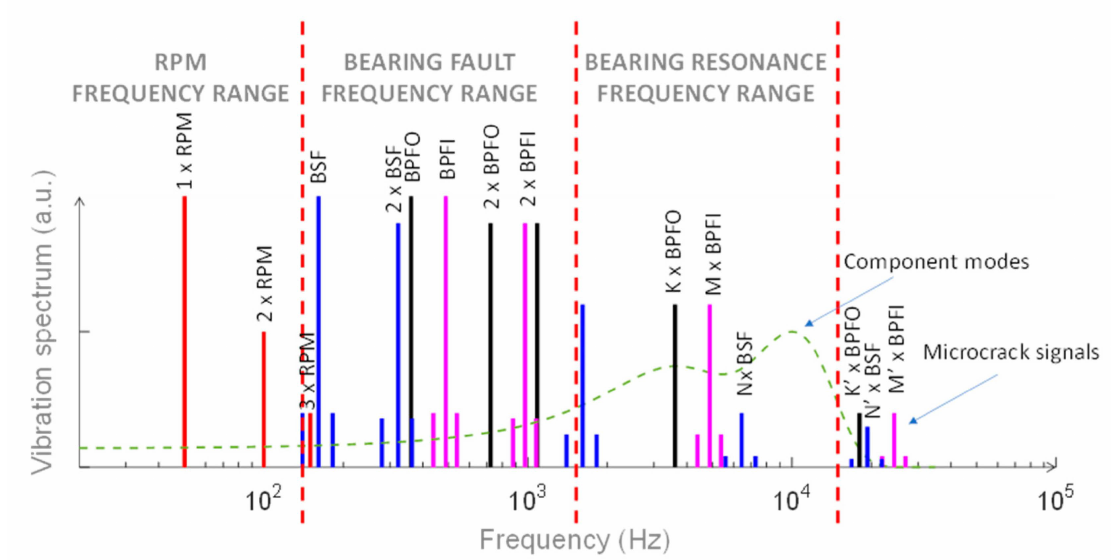
Figure 3. Spectral components of vibration signals due to a fault occurring in rolling bearings, with related frequency